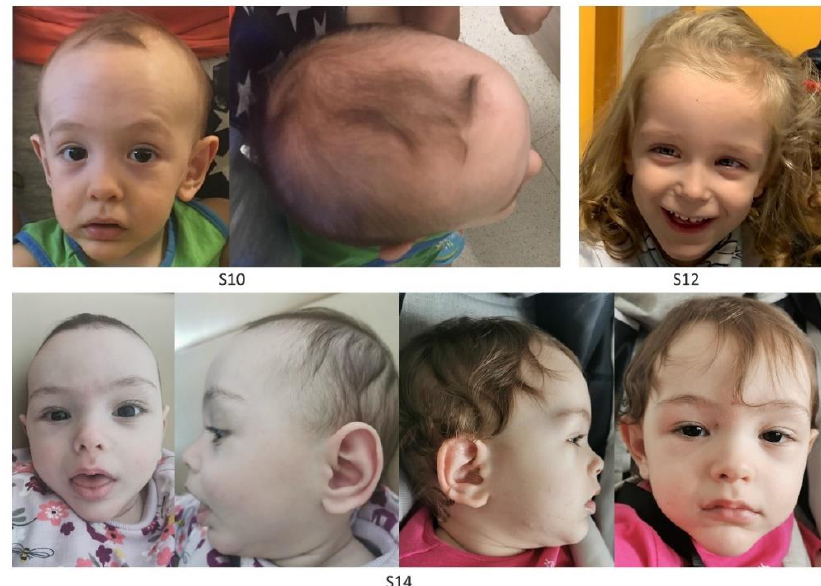
Figure 1. Facies of three subjects with clinical diagnosis of Sotos syndrome carrying functionally unclassified NSD1 variants. Clinical features of S10 (1 year), S12 (2 years) and S14 (6 months, left panels; 1 year and 3 months, right panels) showing typical Sotos syndrome characteristics. All subjects show macrocephaly, dolichocephaly, broad and prominent forehead, sparse fronto-temporal hair, downslanted palpebral fissures, long and narrow face, and a long/pointed chin.